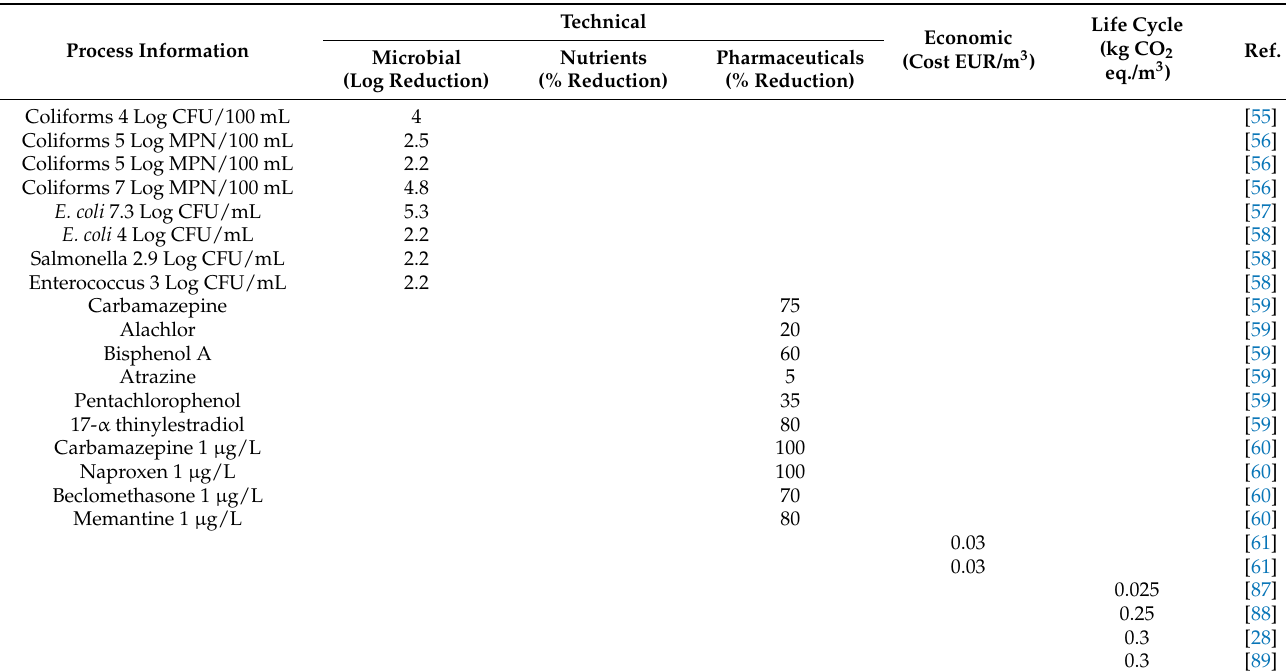
Table A6. Literature data used for scoring the ozonation